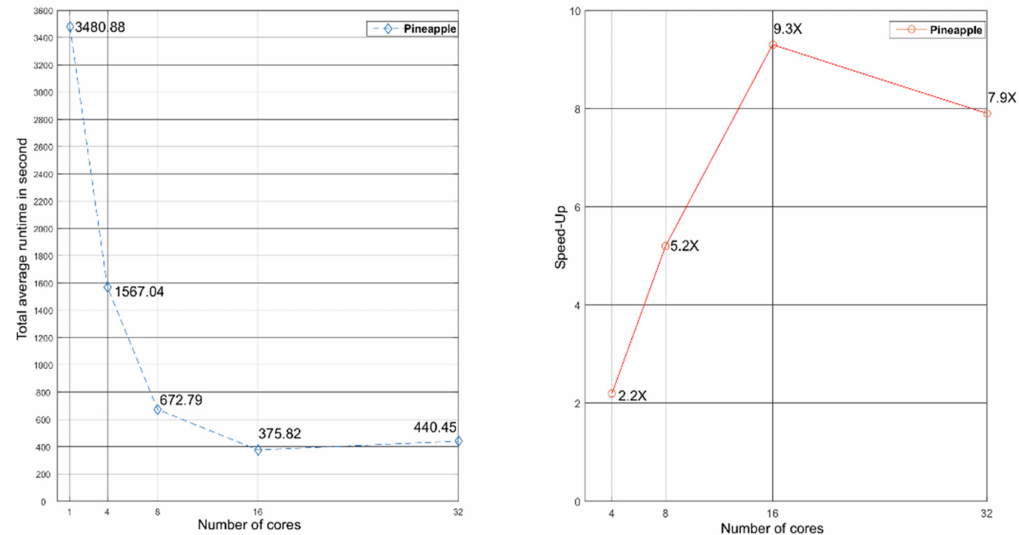
Figure 3. Total average runtime and speed-up of Inpactor using 4, 8, 16 and 32 cores with pineapple